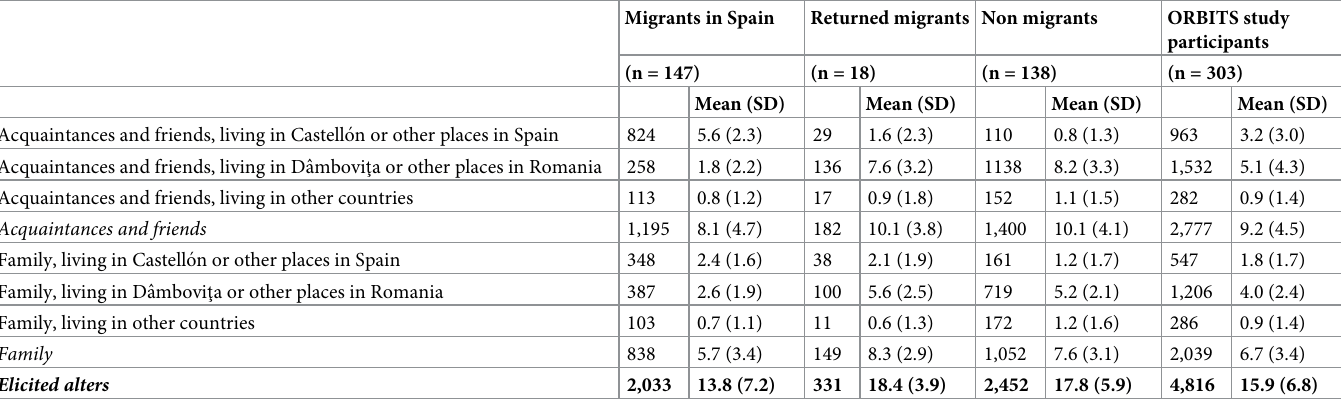
Table 8. Number of alters nominated within the name generators, split by type of